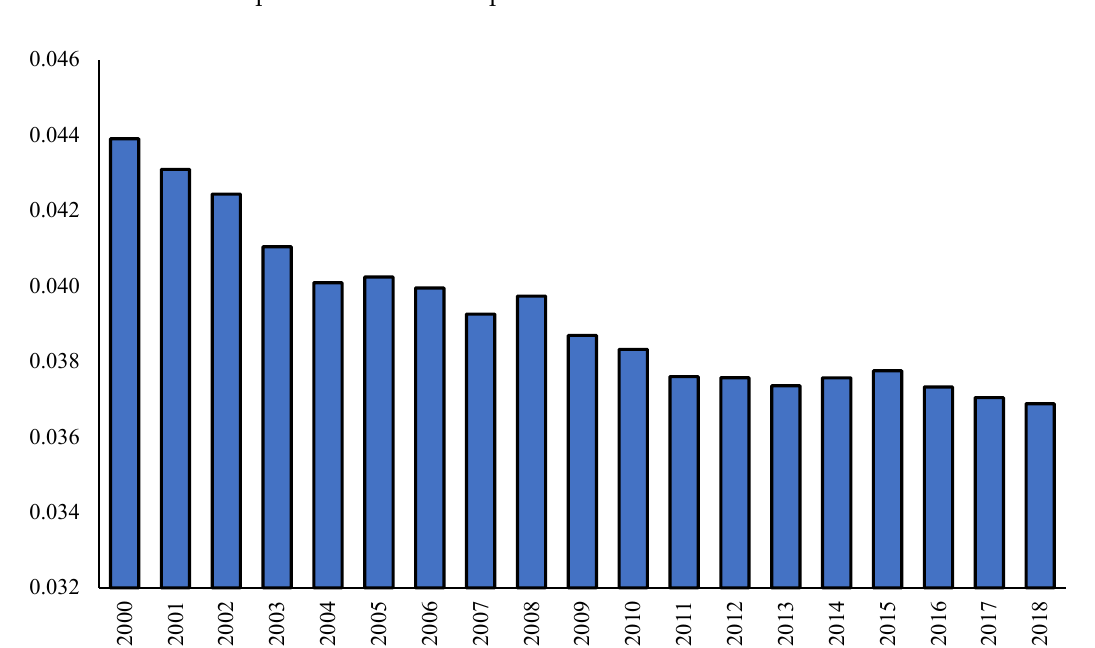
Figure 5. Share of the regional gross product of Zachodniopomorskie in GDP of Poland in 2000–2018.